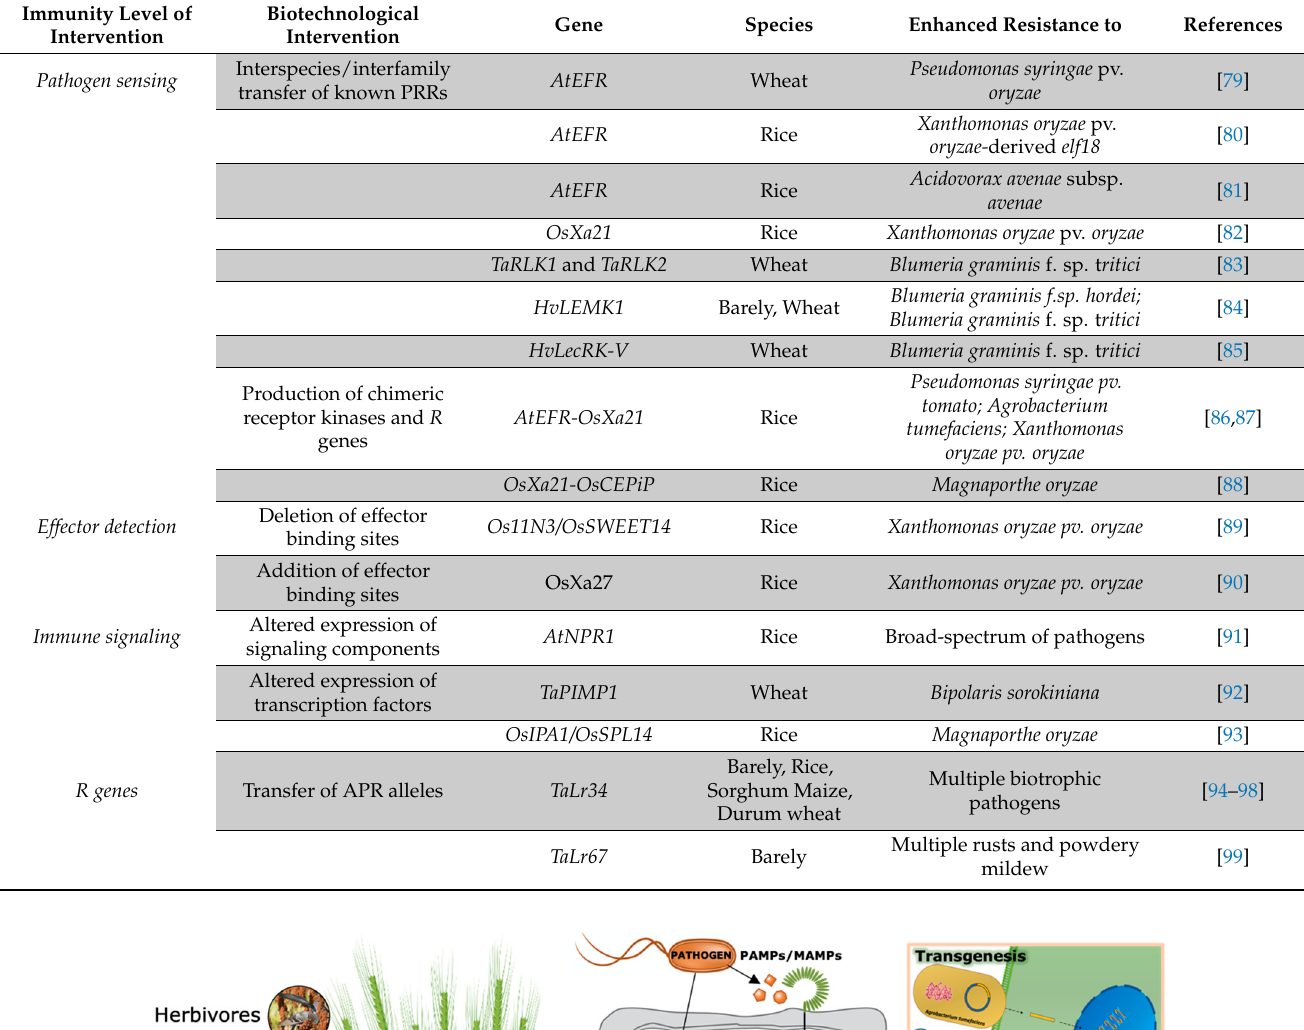
Table 1. Biotechnological interventions to increase disease resistance in cereals.